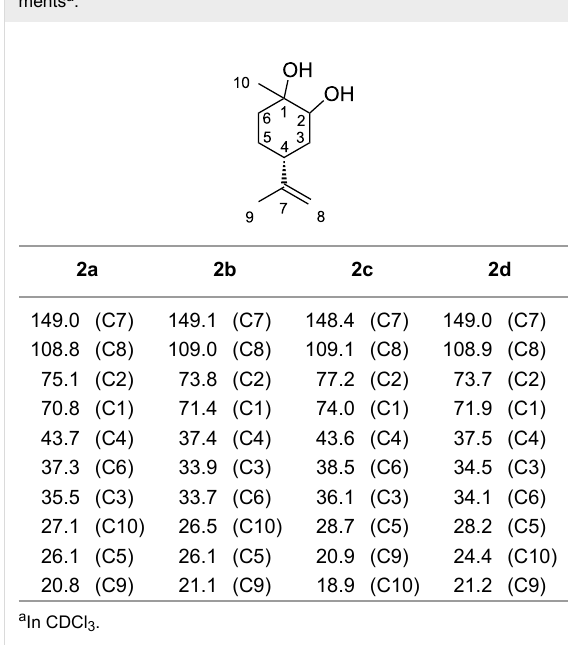
Table 2: Chemical shift values (ppm) of four LMdiols with the assign- ments a .